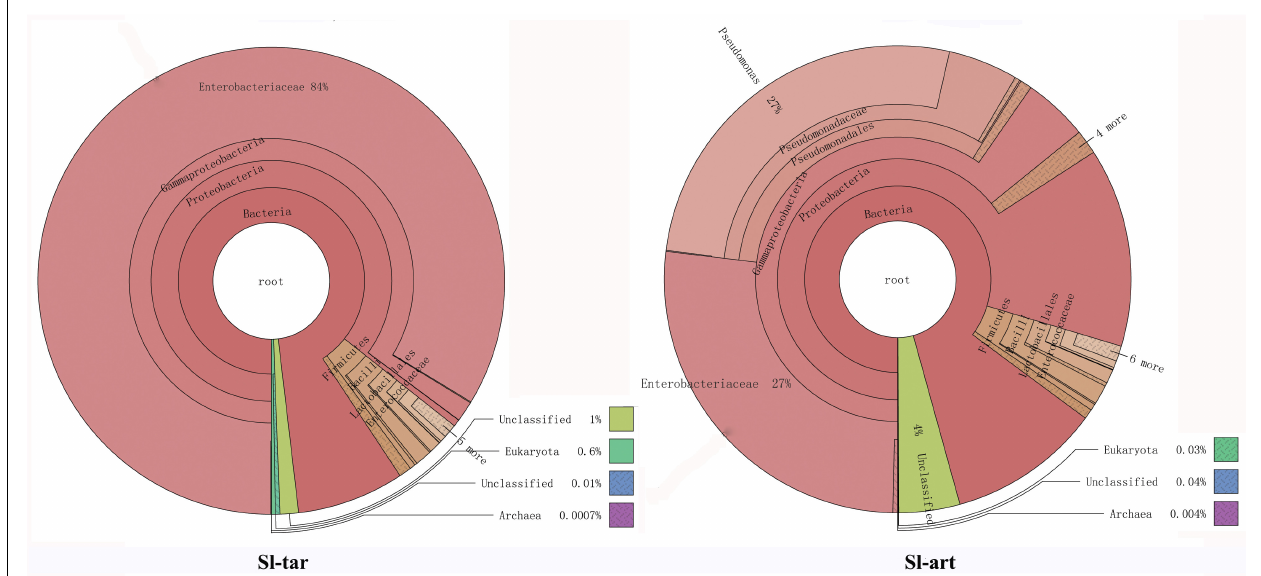
FIGURE 1 | Species annotations of S. litura gut microbes using Krona. Circles represent different classification levels from inside to outside. Sector size represents the relative proportions of different species. Where Sl-tar are S. litura reared on taro leaves and Sl-art are S. litura reared on the artificial diet.